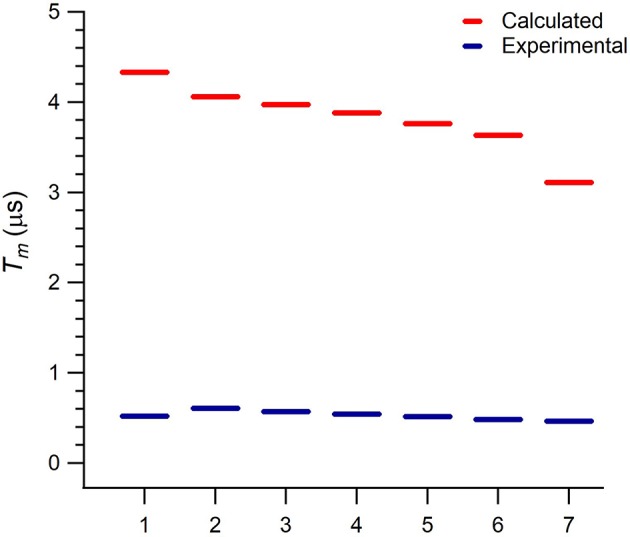
Calculated and experimental phase memory times Tm of 1 at each one of the seven resonant transitions in the explored magnetic field range (1: 0.125 T, 2: 0.19 T, 3: 0.27 T, 4: 0.35 T, 5: 0.43 T, 6: 0.51 T, 7: 0.56 T).